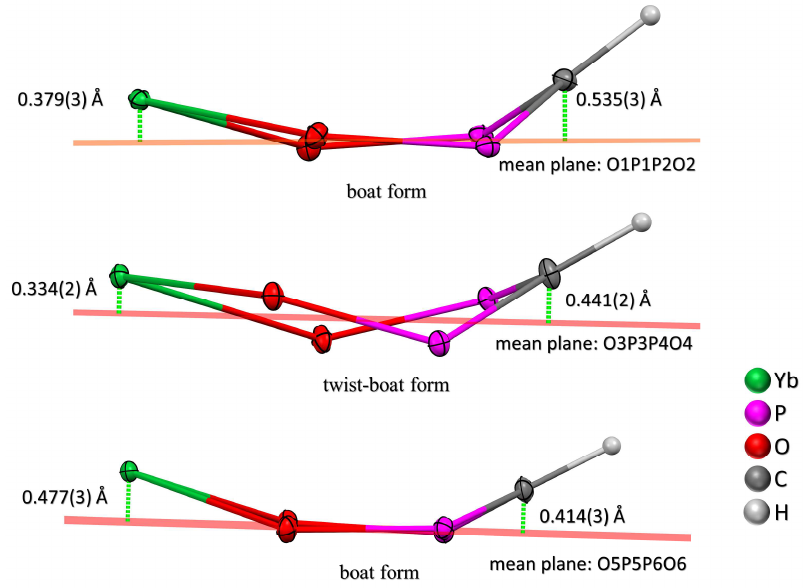
Figure 4. Arrangement of phenyl groups on P atoms within the metallacycle of complex.